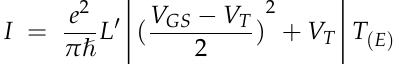
Figure 10. I- VGS characteristic for different values of Z at room temperature (S = 10).